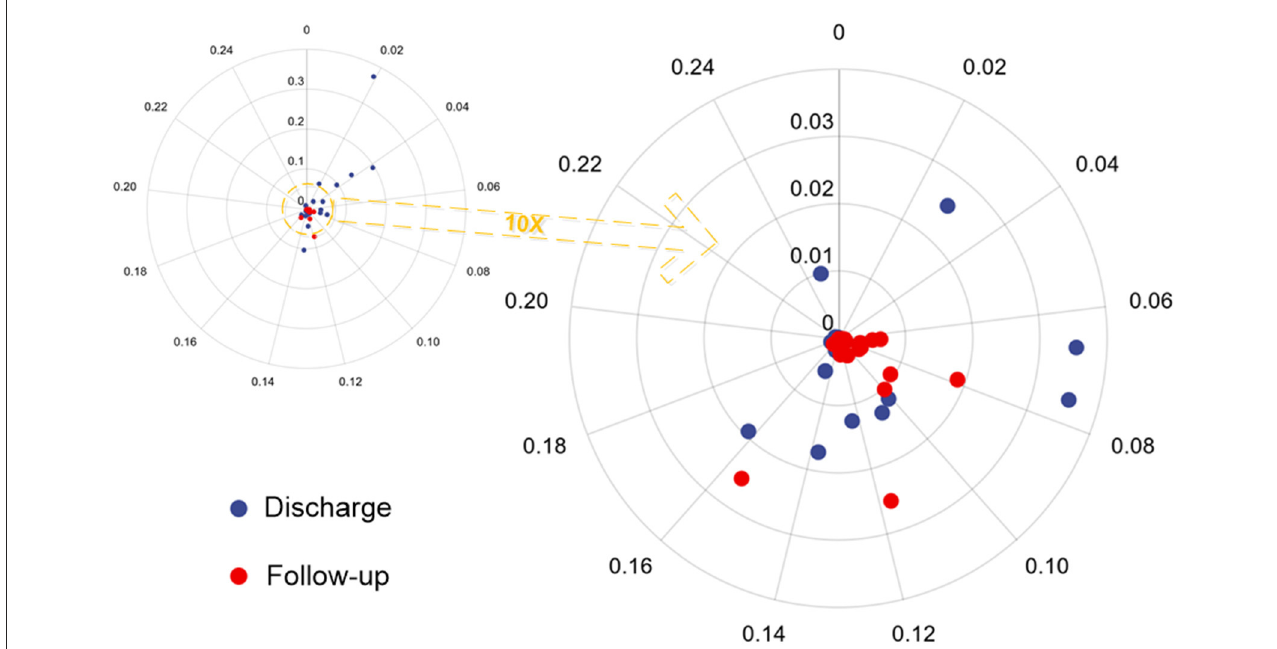
FIGURE6 Polar scatter plot based on the lesion volume ratio and median lesion severity from hospital discharge and follow-up CT. The image on the left becomes the image on the right after enlarging 10 times.